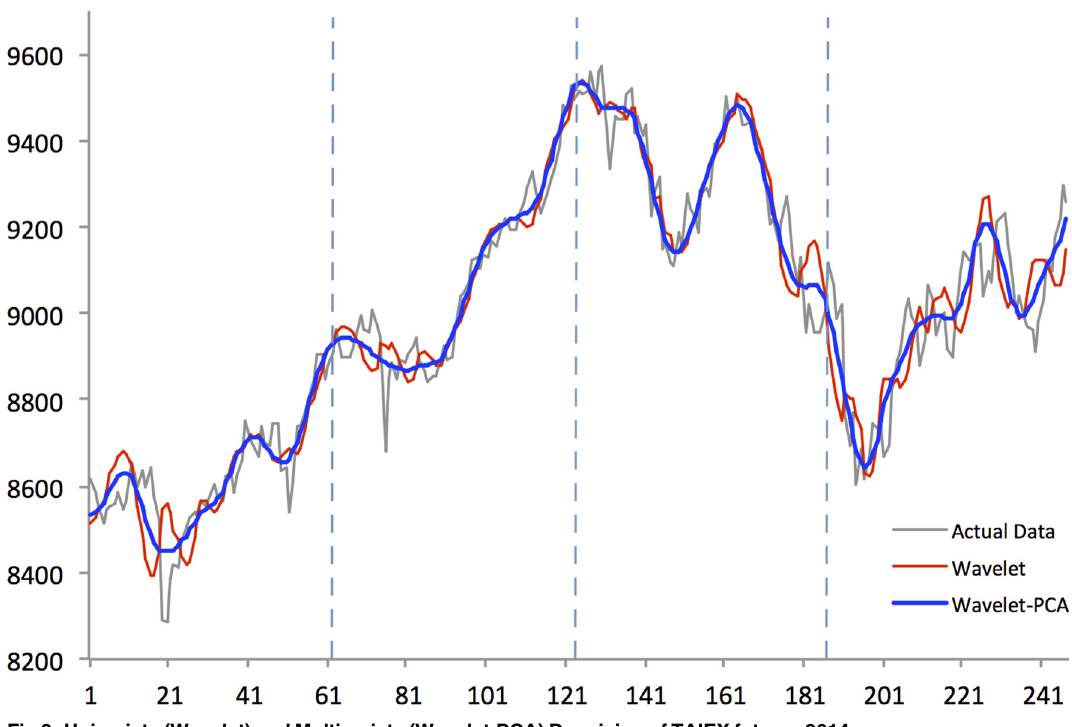
Fig 8. Univariate (Wavelet) and Multivariate (Wavelet-PCA) Denoising of TAIEX futures